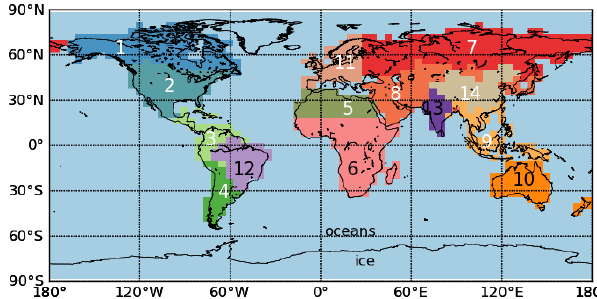
Fig. 6. Geographic regions used in this study: 1 = boreal North America, 2 = temperate North America, 3 = tropical South Amer- ica, 4 = temperate South America, 5 = North Africa, 6 = southern Africa, 7 = boreal Eurasia, 8 = temperate Eurasia, 9 = tropical Asia, 10 = Australasia, 11 = Europe,12 = Brazil, 13 = India, 14 =